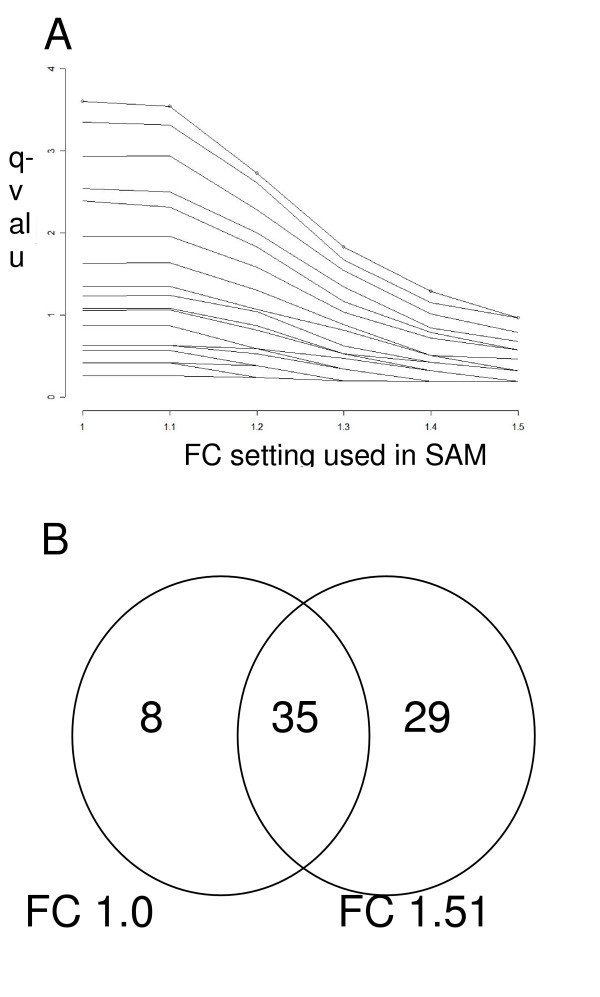
FC effects individual q-values: q-values of all genes scored as significant in the brain aging study (reduced data set) at FC 1.51 at other FC settings. Genes only acquires discrete q-values and all 538 genes are shown, but overlap. (B) Running SAM with different FC settings changes the biological interpretation: Venn diagram comparing the number of significantly overrepresented classifications (EASE score <0.05) using the reduced brain aging data set analysed either with a 1.0 FC setting (314 genes) or a 1.5 FC setting (538 genes).